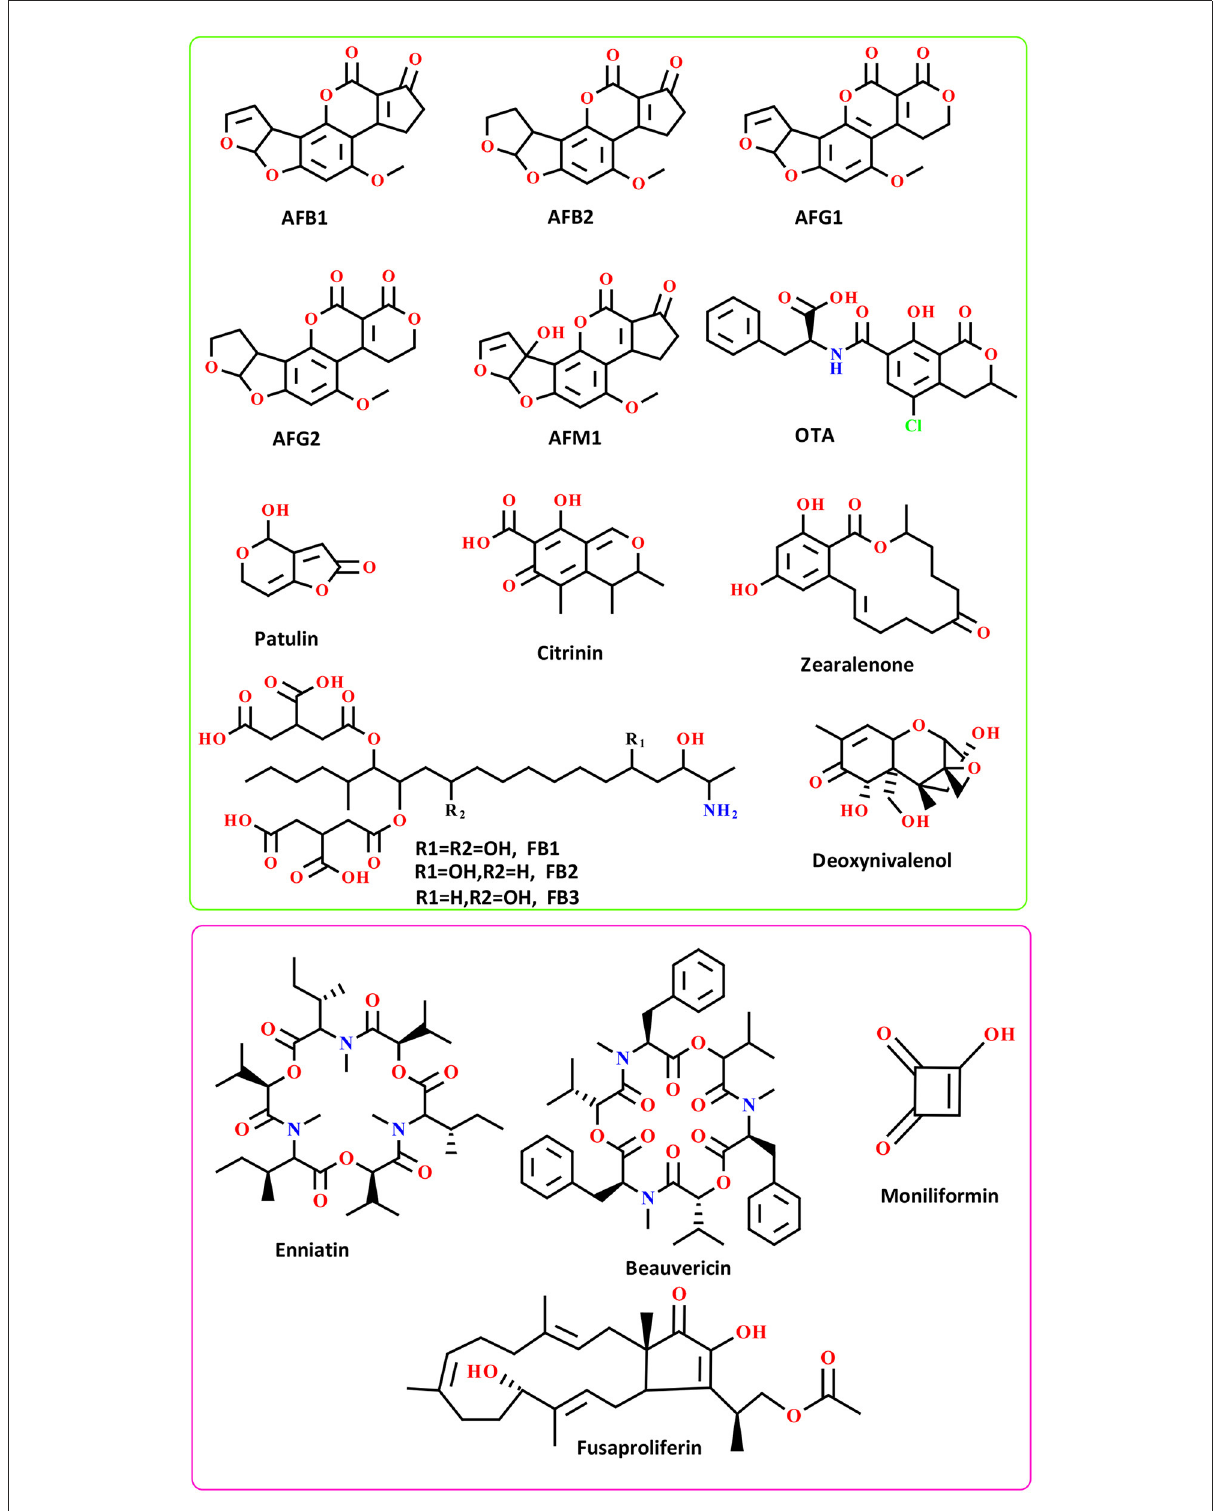
FIGURE1 The chemical structure of well-known AFs (green box) and emerging mycotoxins (pink box); FB: Fumonisins B.